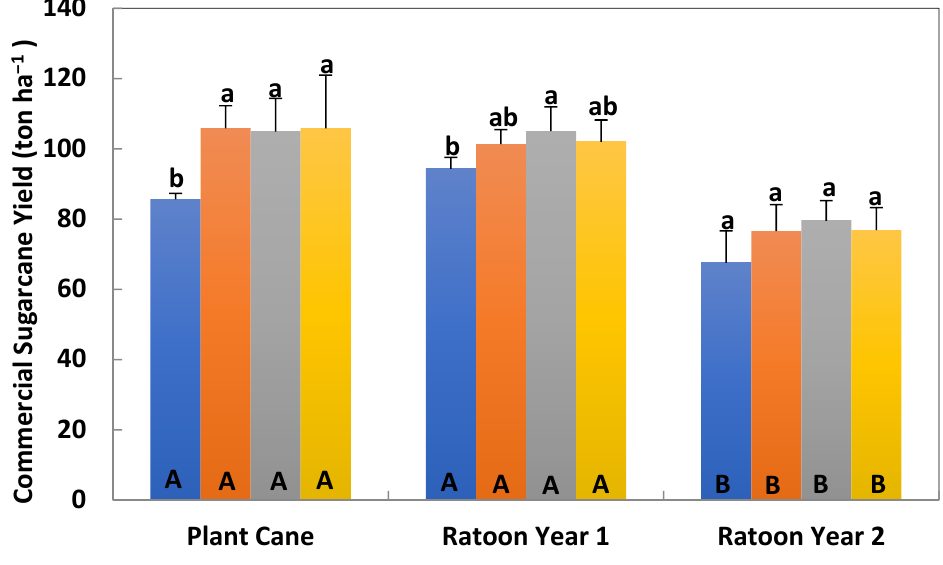
Figure 3. Commercial sugarcane − yield for plant cane and two ratoons (mean and standard deviation). Different lower case letters within the same crop year are significantly different ( p < 0.05). The same treatment with different upper case letters for plant cane and two ratoons are significantly different ( p < 0.05).